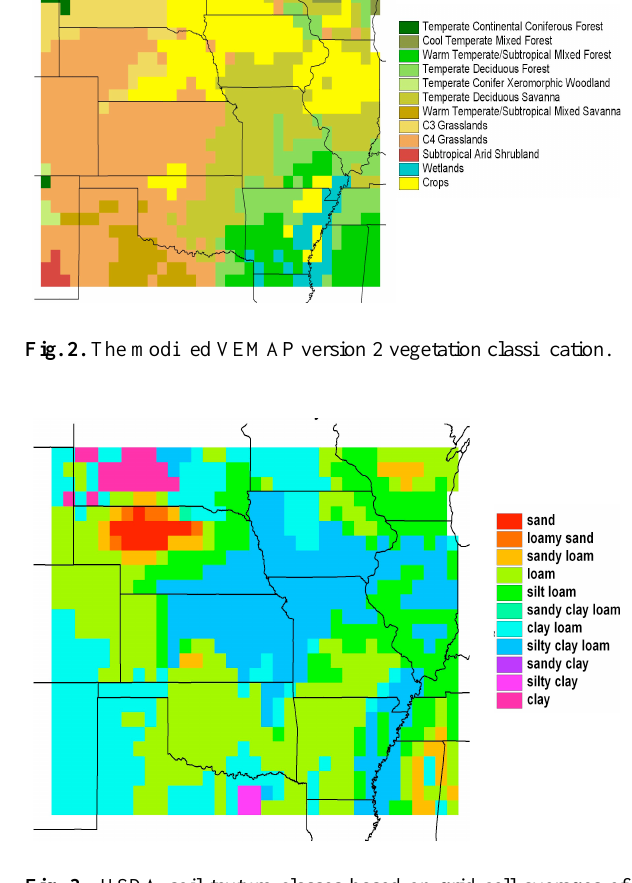
Fig. 3. USDA soil texture classes based on grid-cell averages of sand, silt and clay percentages in the VEMAP